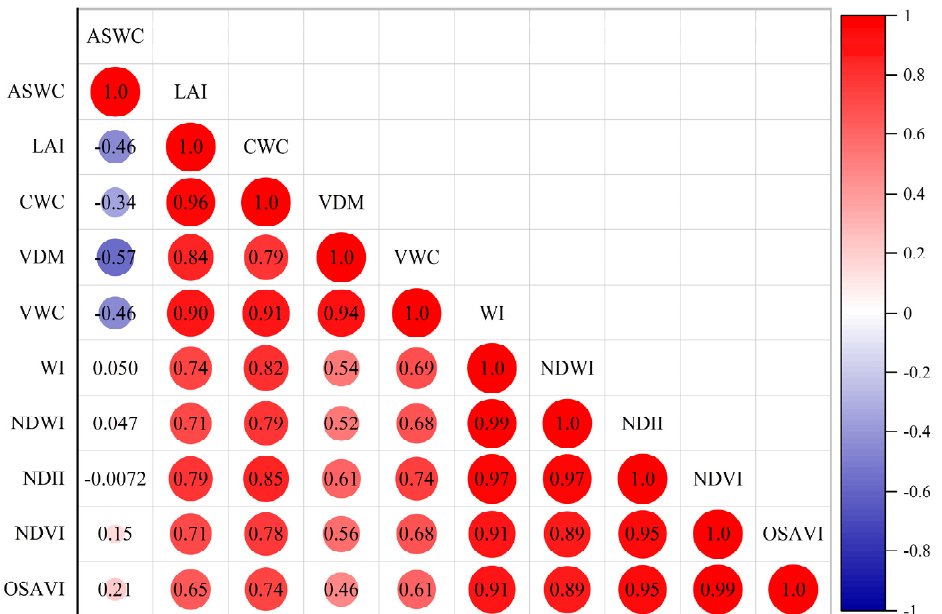
Figure 6. A visualization of Pearson correlation matrix of canopy characteristics and the spectral vegetation indices. ASWC, available soil water content; LAI, leaf area index; CWC, canopy water content; VDM, vegetation dry mass; VWC, vegetation water content; WI, water index; NDWI, normalized difference water index; NDII, normalized difference infrared index; NDVI, normalized difference vegetation index; and OSAVI, optimal soil-adjusted vegetation index.